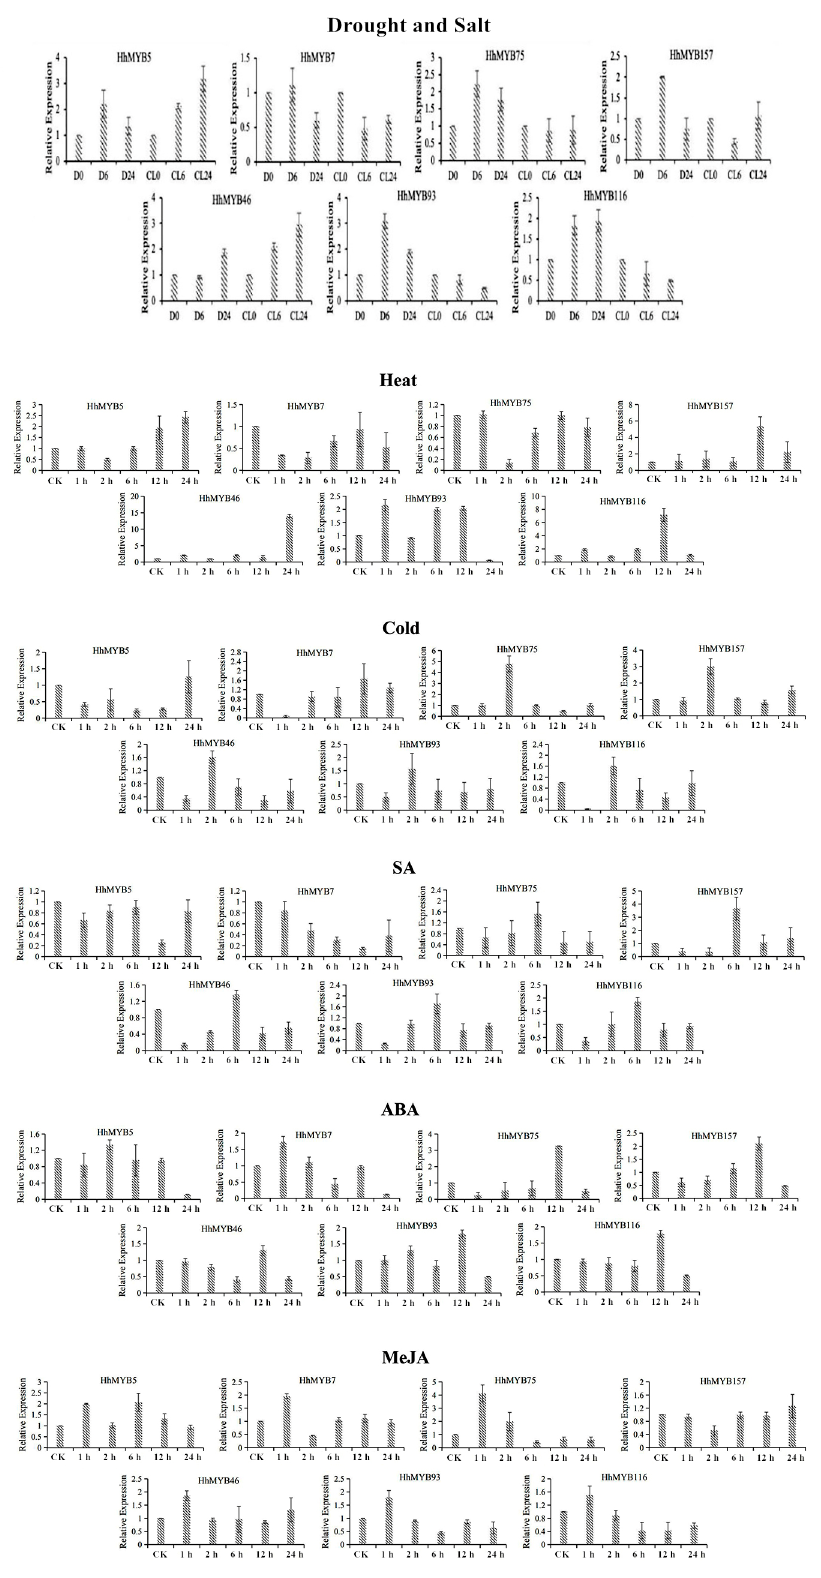
Figure 3. Expression pattern of HhMYB genes in H. hamabo under 500 mM mannitol (Drought), 400 mM NaCl (Salt), 42 °C (Heat), 4 °C (Cold), 200 μ M salicylic acid (SA), 50 μ M abscisic acid (ABA), or 1 mM methyl jasmonate (MeJA) treatments. D0, D6, D24, CL0, CL6, and CL24 represent treatments for 0 h, 6 h, and 24 h under drought stress and 0 h, 6 h, and 24 h under salt stress, respectively.